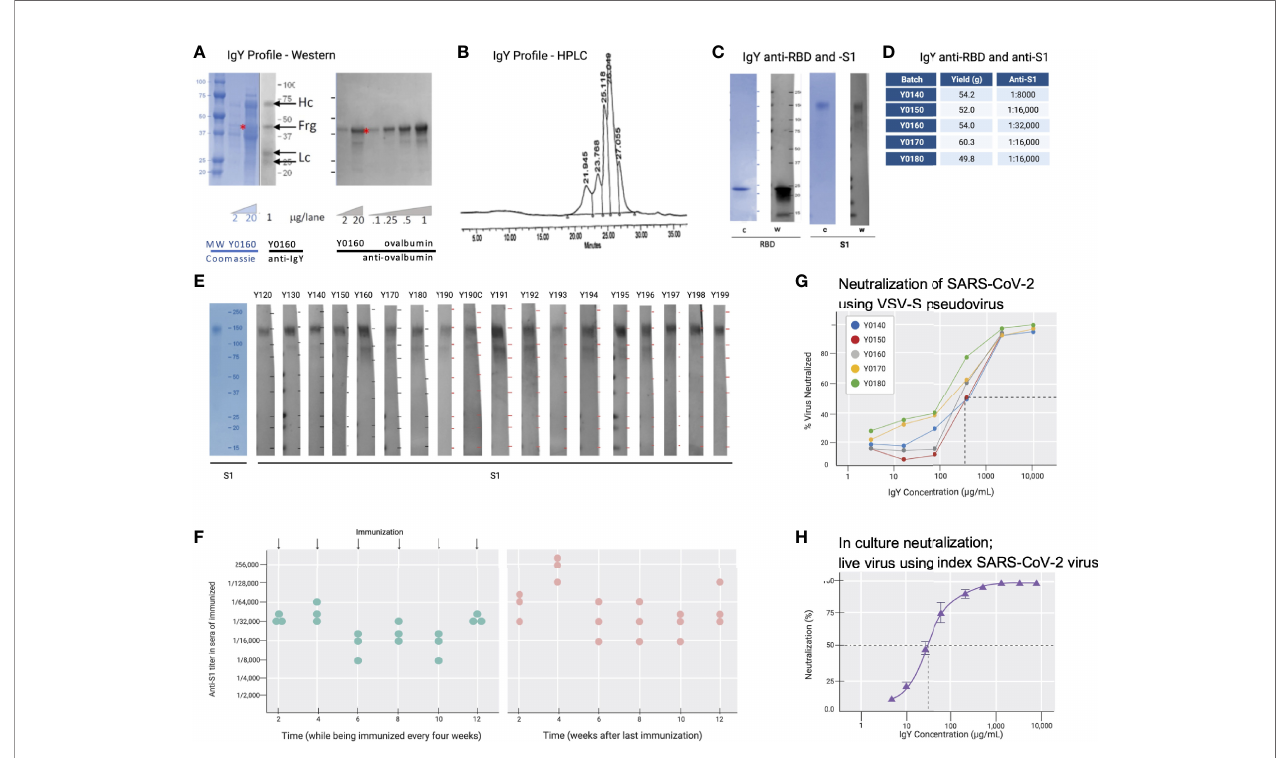
FIGURE 3 | IgY puri fi cation and characterization. (A) Western blot analysis of the IgY preparation. (B) HPLC pro fi le of the IgY preparation. (C) Western blot analysis of anti-SARS-CoV-2 IgY against RBD fragment and full S1 recombinant protein. (D) IgY yield for various batches derived from 100 eggs each. (E) Western blot data of different lots of anti-SARS-CoV-2 RBD IgY (Y0120-Y0199). Pools of 100 eggs laid by 9 hens over 2 weeks were used for each pool of IgY preparation between May 2020 and March 2021. IgY lot samples were diluted 1:500 followed by a 1:3000 dilution of rabbit anti-IgY HRP conjugate. First left lane shows the Coomassie stain of the same gels. (F) Time-dependent ELISA titers of sera from 3 individual hens following continual immunization (left); arrows indicate immunization timing. Time-dependent ELISA titer of 3 hens after immunization was stopped for up to 12 weeks (right). (G) Neutralization of pseudovirus SARS-CoV-2 by various lots of anti-SARS-CoV-2 RBD IgY (conducted at RetroVirox). (H) Neutralization of live index SARS-CoV-2 virus by anti-SARS-CoV-2 RBD IgY (Y0180, conducted at